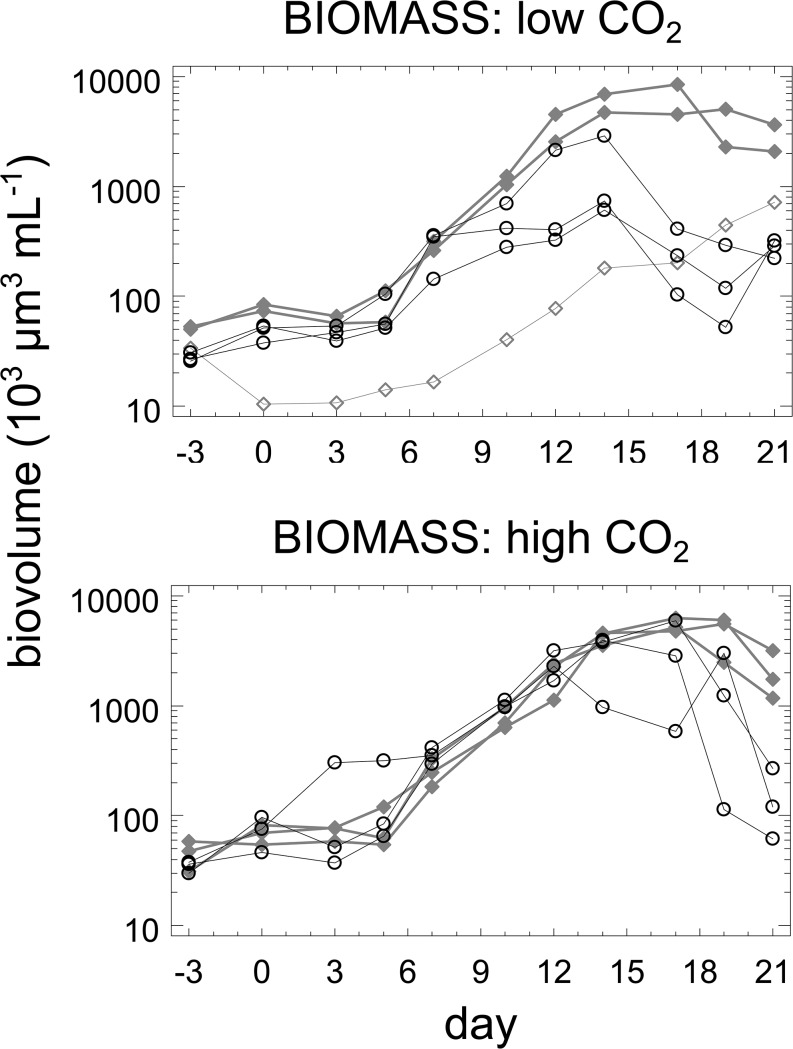
Time course of phytoplankton biovolumes.Open circles: warm mesocosms; grey and filled diamonds: cold mesocosms; open diamonds: mesocosms 9.